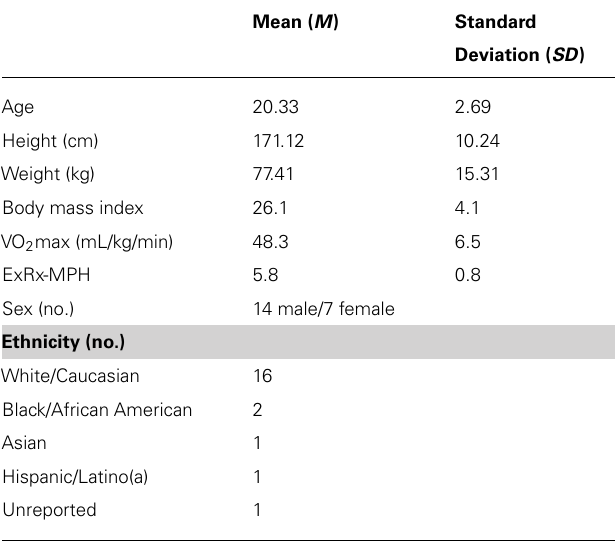
Table 1 | Descriptive statistics for subjects’ baseline and post-exercise